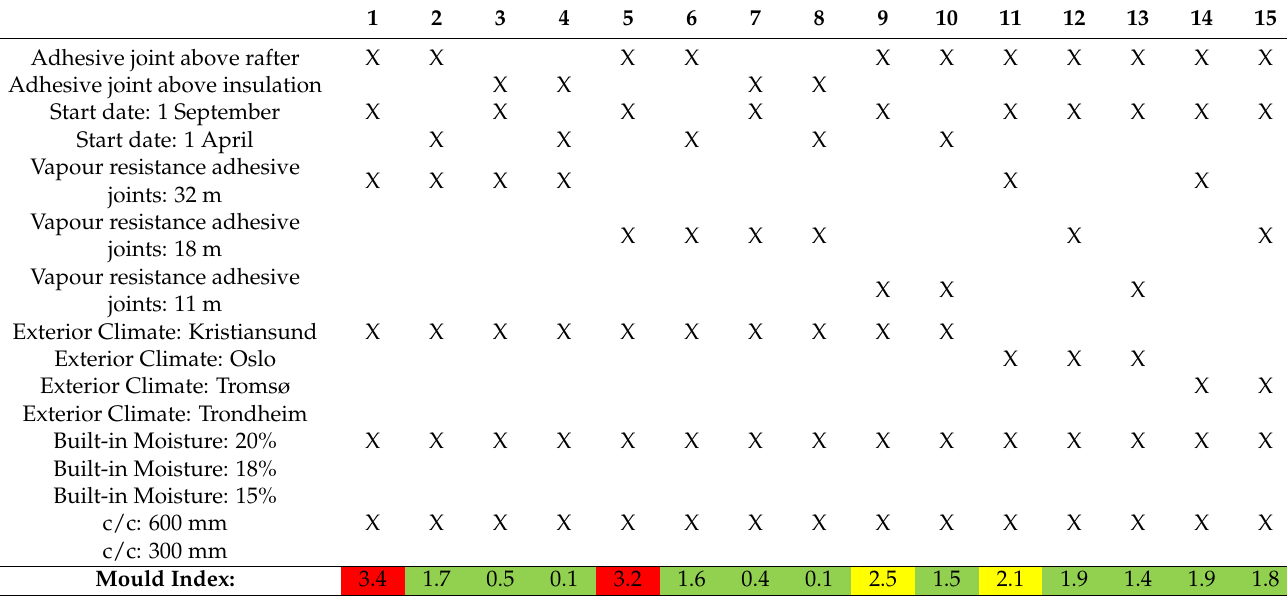
Table 6. Parameter Study and Results from Simulation in WUFI 2D and WUFI Mould Index VTT. Calculations